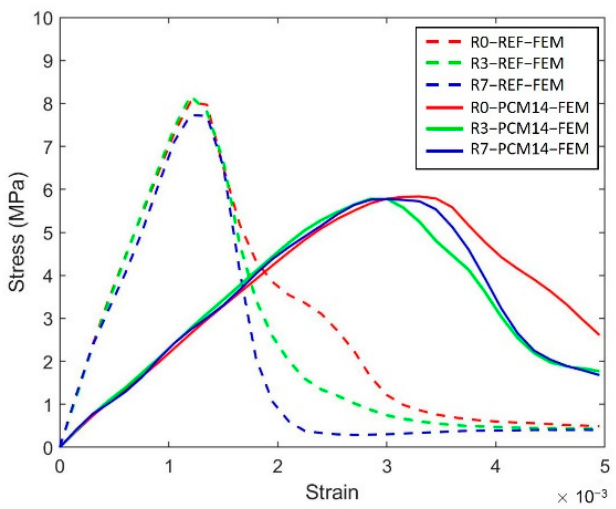
Figure 22. Simulated stress–strain curves of the LCCCs and 3% of air content are used for simulation. Still, a discrepancy can be found at post peak branch between the experimental results and the simulated curve: the experimental results show higher toughness compared to